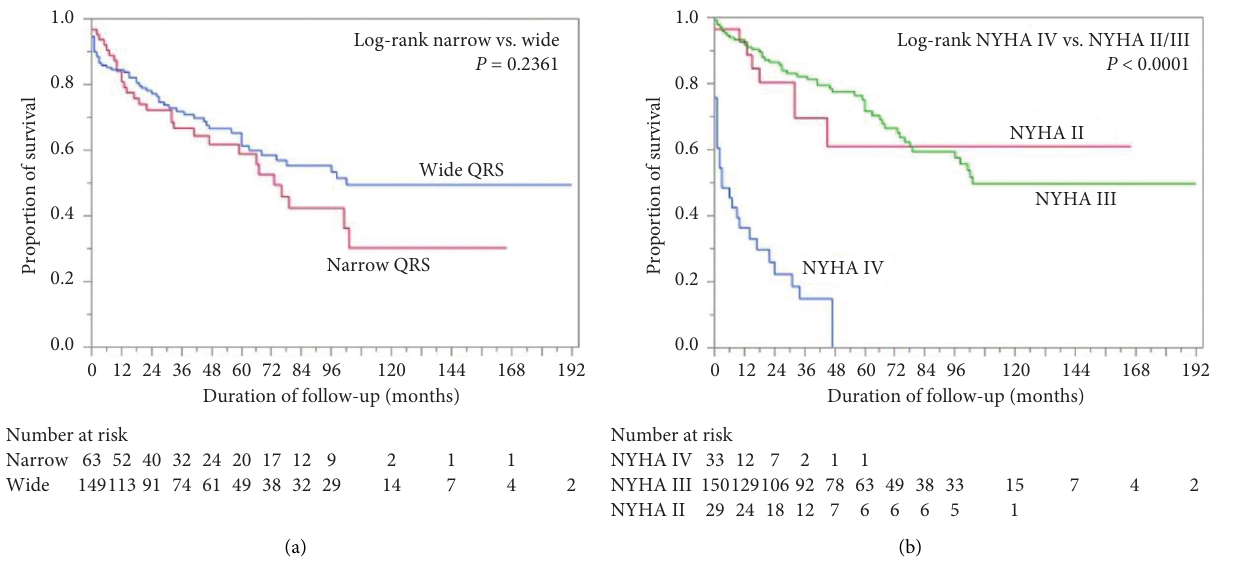
Figure 2: (a) Survival curves for narrow and wide QRS groups. There is no significant difference between the two groups. (b) Overall survival based on severity of heart failure severity. (a) Survival curves: wide QRS versus narrow ORS group. (b) Overall survival based on severity of heart failure at